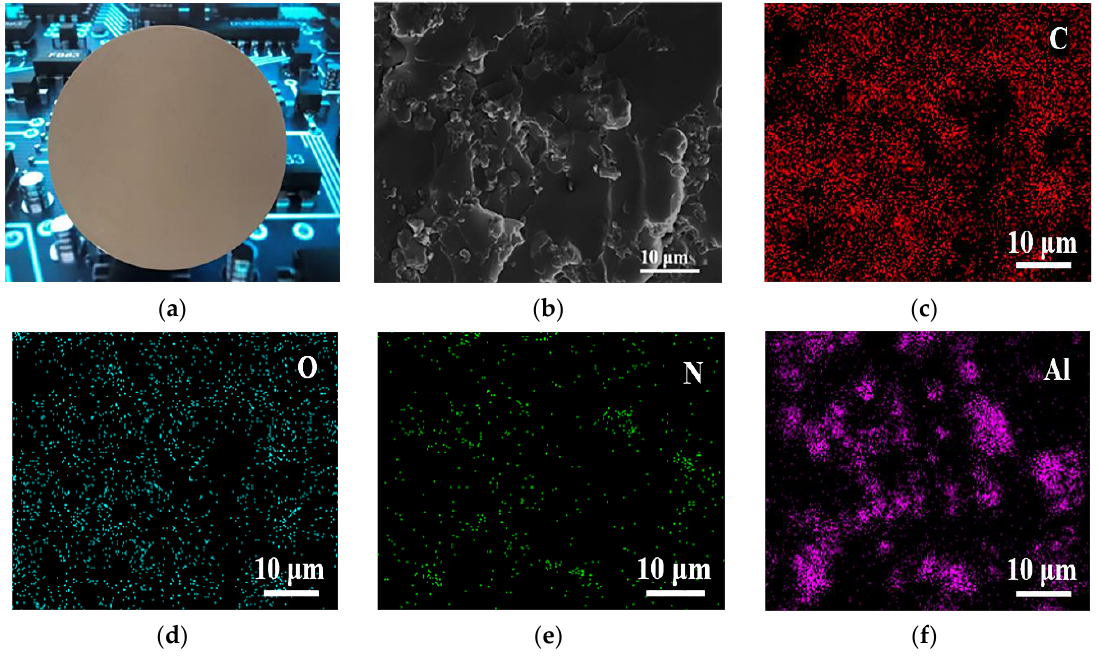
Figure 5. ( a ) Photographs and ( b ) SEM images of 20-AlN/DG-ER sheet, EDS of ( c ) C, ( d ) O, ( e ) N and ( f )